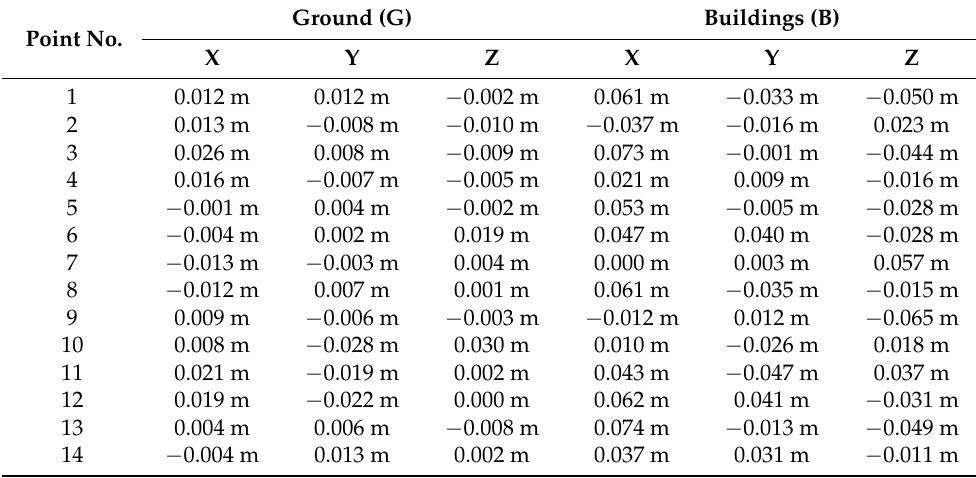
Relative positional coordinate discrepancies between terrestrial laser scanning and UAV